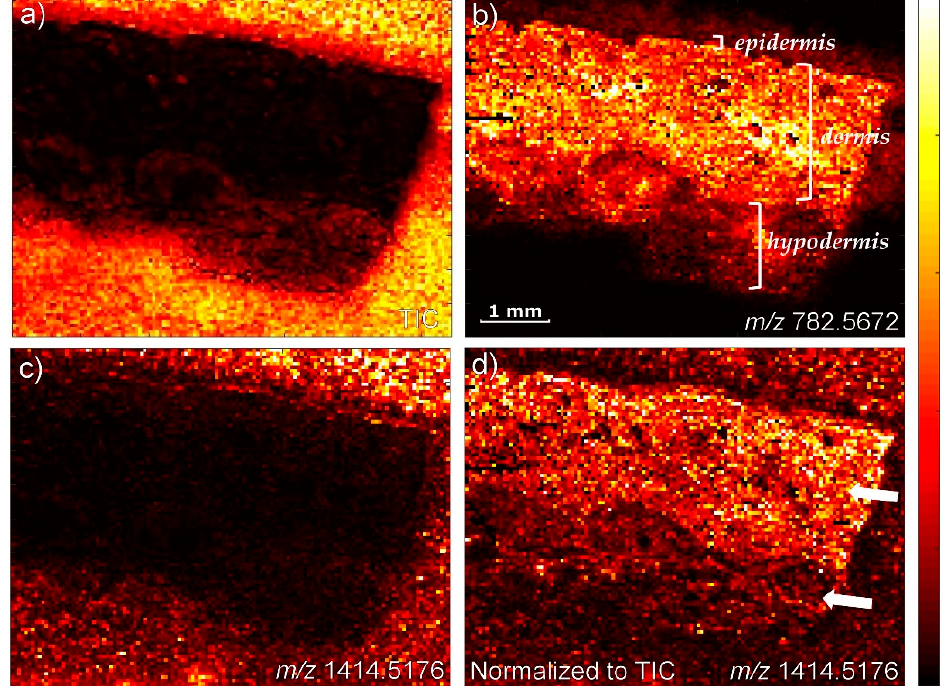
Figure 4. MALDI images of porcine skin after homogenous deposition of a layer of bleomycin. ( a ) TIC image. Outside the tissue, MALDI matrix peaks contribute greatly to the TIC. ( b ) The endogenous lipid PC(34:1) ( m/z 782.5672), normalized to the TIC. The different histological regions in the skin are marked. ( c ) Bleomycin A2, not normalized ( m/z 1414.5176). ( d ) Bleomycin A2, normalized to TIC ( m/z 1414.5176). The image was acquired with 50 µ m pixel